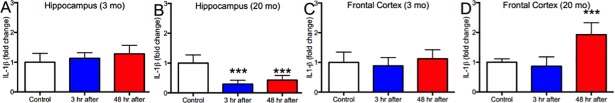
Isoflurane produces age- and region-dependent changes in IL-1β gene expression.3 and 20-month-old mice were anesthetized with 1.2% isoflurane in 30% oxygen for 4 h and sacrificed 3 h or 48 h later and IL-1β measured in the hippocampus and frontal cortex by RT-PCR. Isoflurane had no effect in either region in young mice (panels A & C). In contrast, it produced a marked and sustained decrease in IL-1β mRNA in the hippocampus and an increase in the cortex 2 d later in aged mice (panels B & C) demonstrating age and region specific effects of treatment with isoflurane. Data expressed as mean ± SD for N = 6 animals per treatment condition. *** p<0.001 relative to age-matched controls by 1-way ANOVA with Dunnett’s test for multiple comparisons.